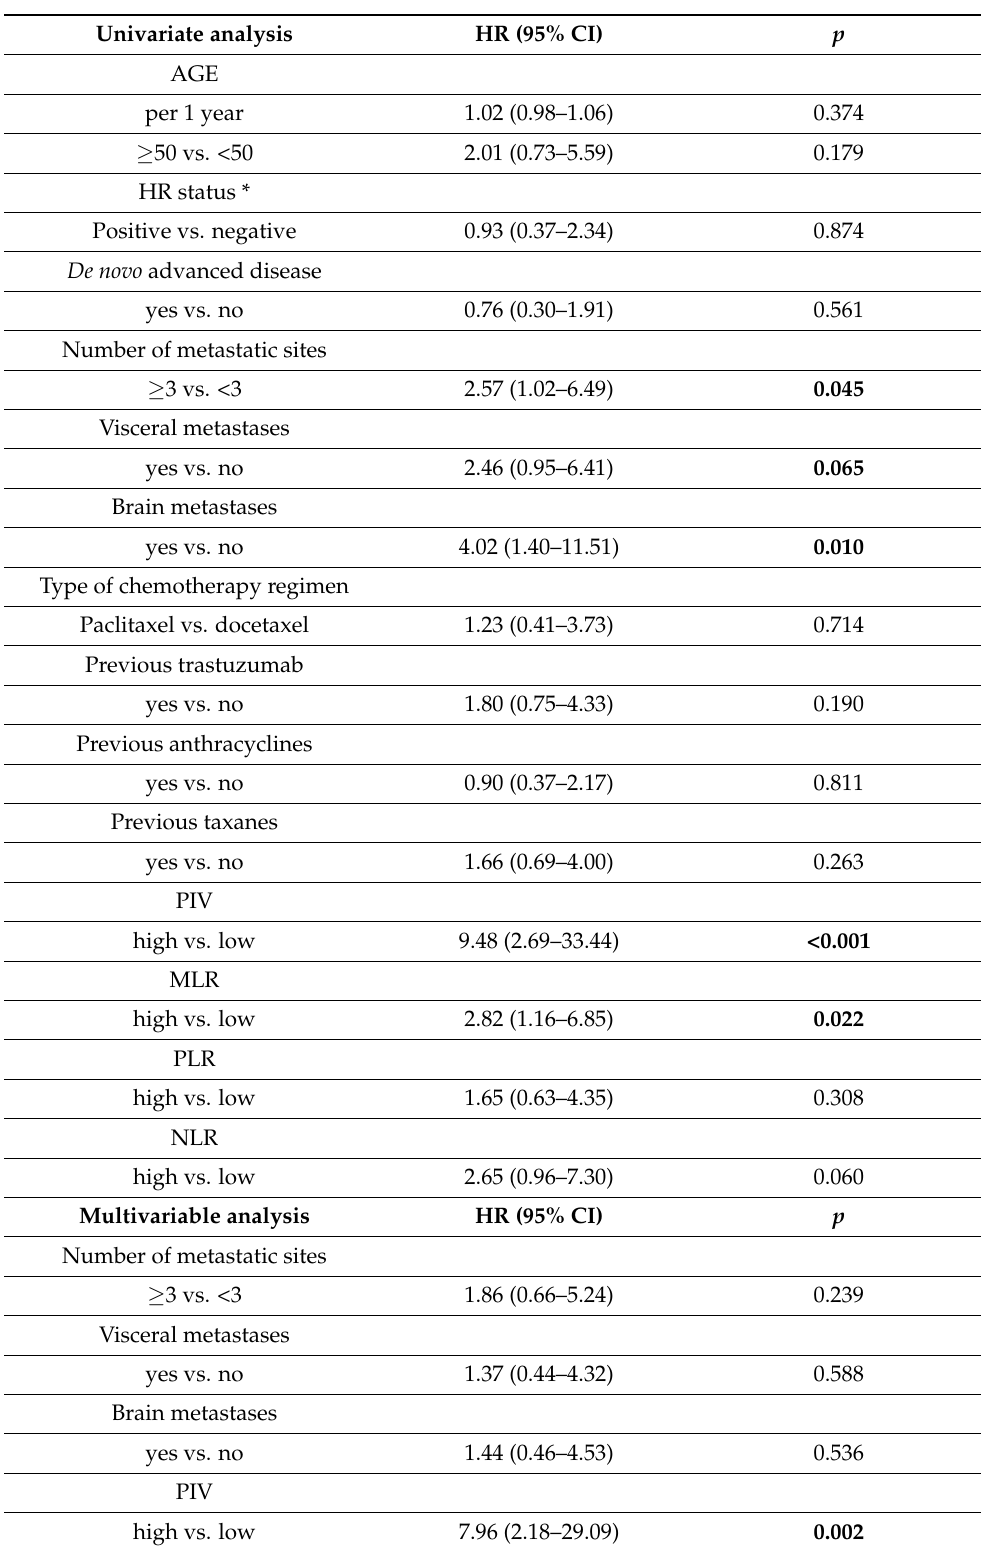
Table 3. Univariate and multivariable Cox proportional hazards model for